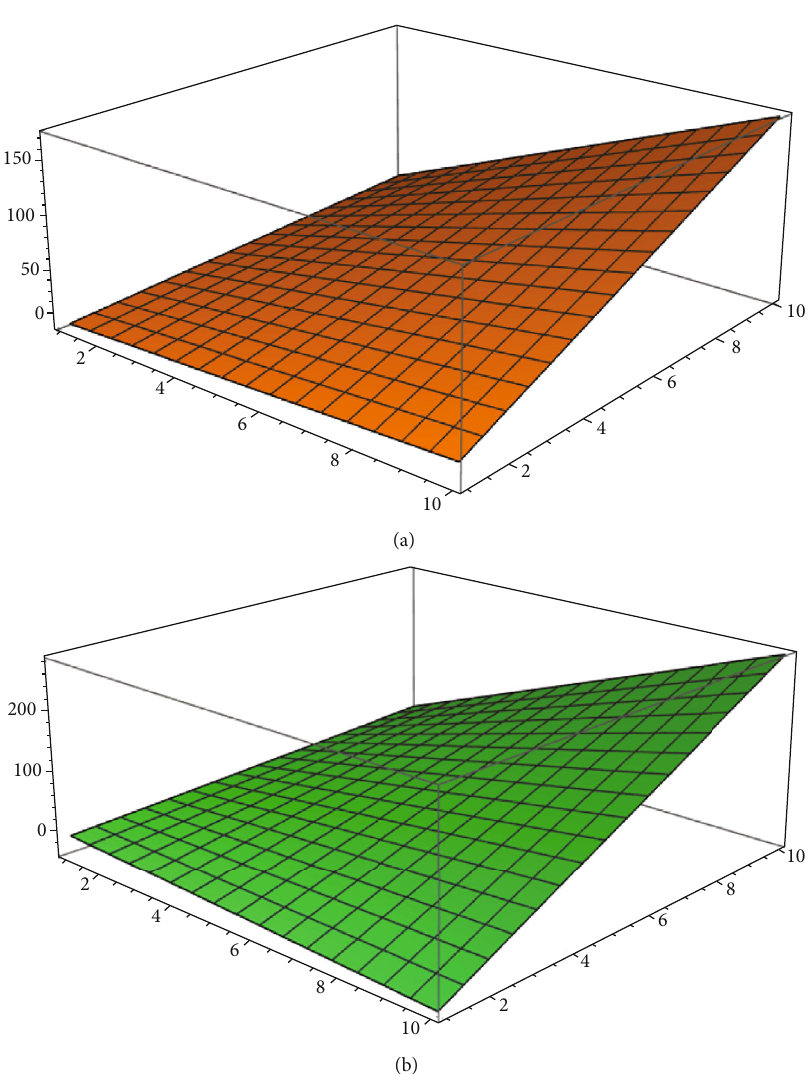
Figure 7: (a) Ve-deg-based harmonic index and (b) ve-deg-based sum connectivity